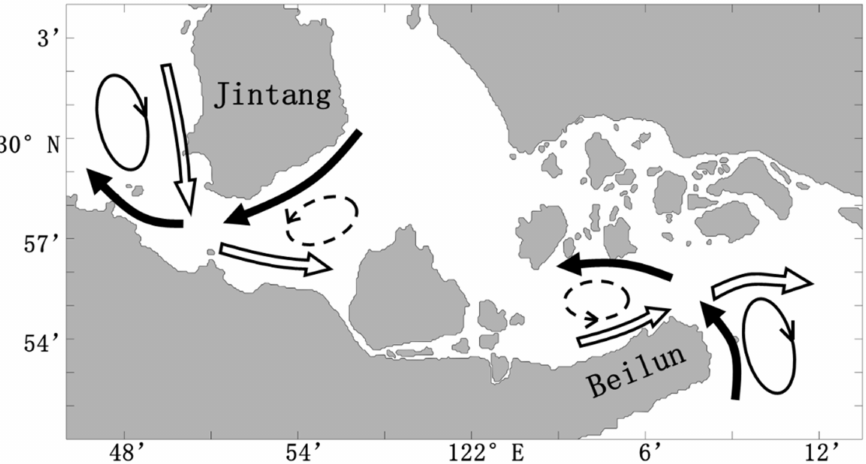
Figure 10. Sketch map of residual circulations around the Beilun Headland and Jintang Island. Solid arrows represent flood flows; hollow arrows represent ebb flows. Solid rings indicate clockwise circulations; dashed rings indicate anticlockwise